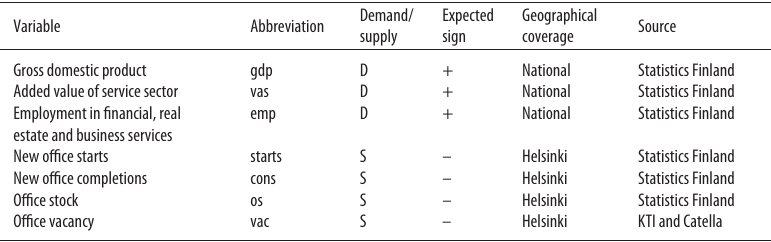
Fig. 3. Demand and supply side variables that are incorporated in the